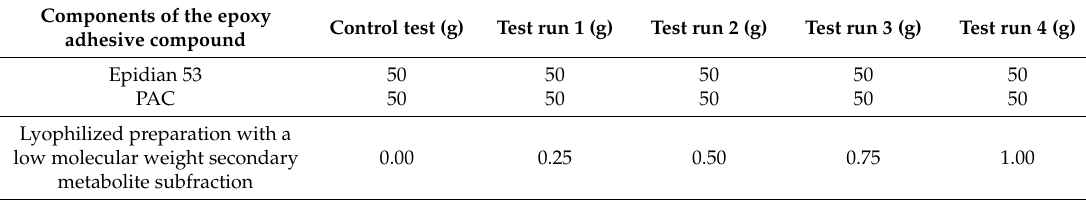
Table 1. Modified adhesive compounds.